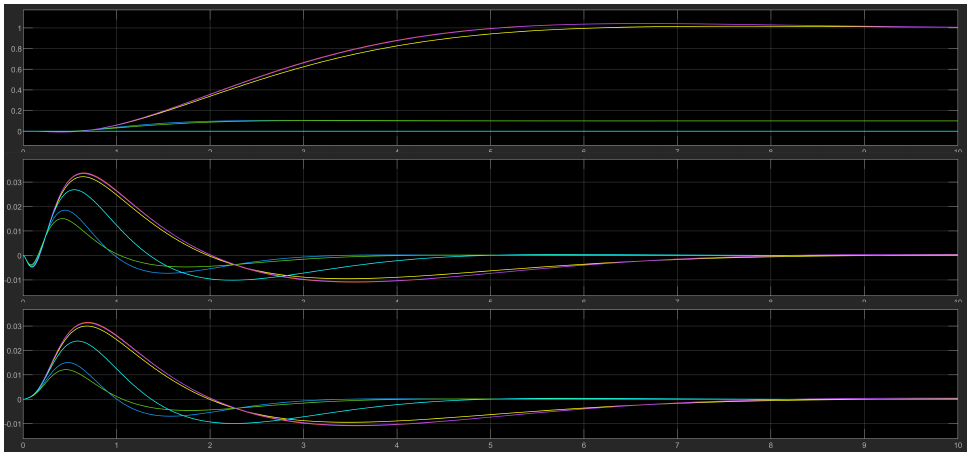
Figure 7. Step response of all 6 cases (including the initial one). Yellow—Initial simplest form, Blue— 1st case (very close to green), Orange—2nd case (very close to purple), Green—3rd case, Purple—4th case, Light Blue—5th